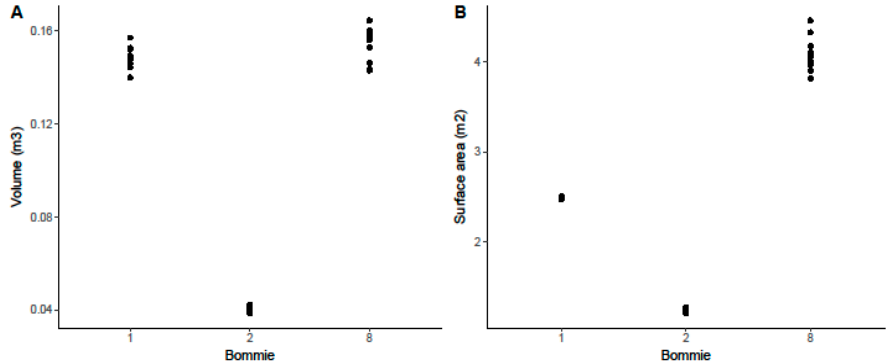
Figure 2. Measurements resulting from successive manual cropping of ( A ) volume and ( B ) surface area of a single mesh constructed once for three bommies.